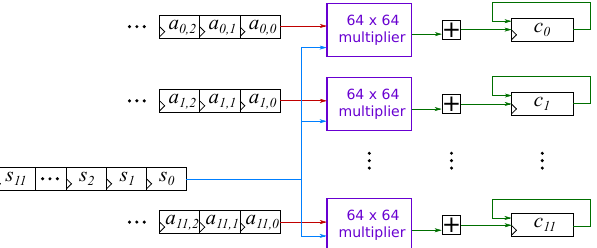
Figure 3: Parallel architecture for matrix-vector multiplication in Espada